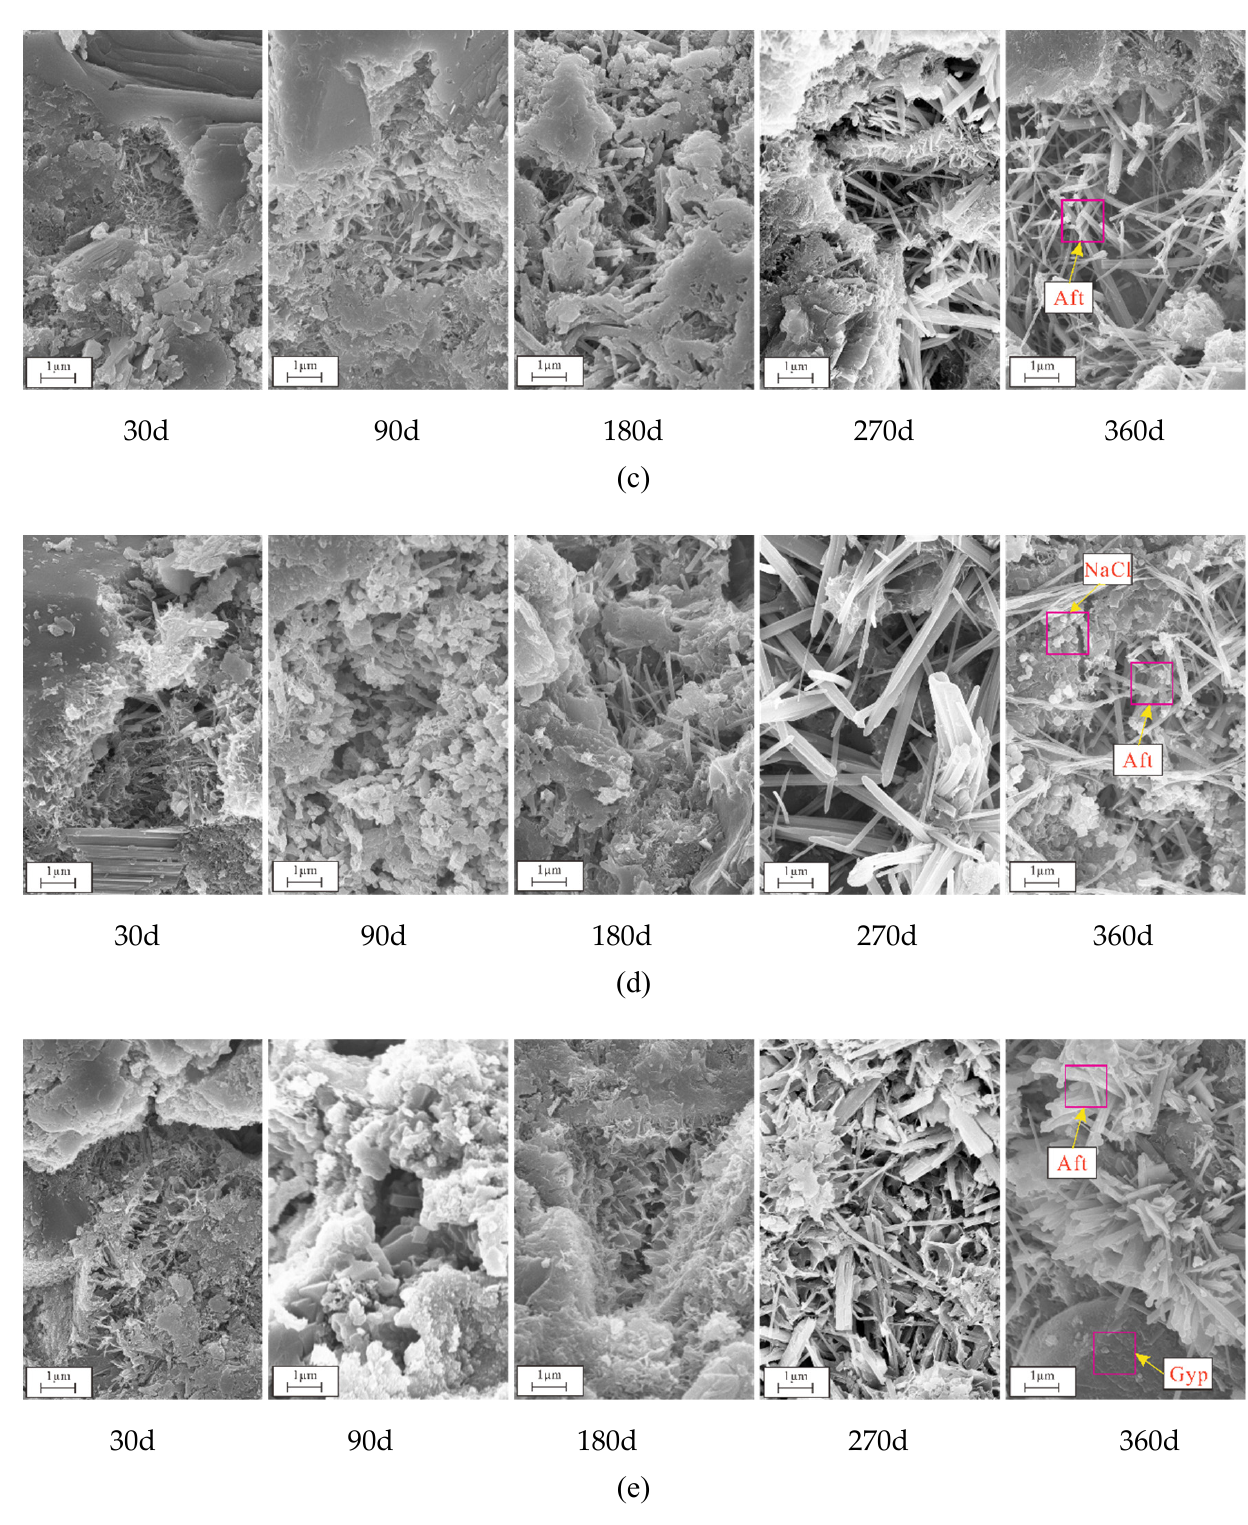
Figure 9. SEM images of samples in different erosion solutions: ( a ) CS0, ( b ) CS0.5, ( c ) CS1, ( d ) CS2, ( e ) CS3.